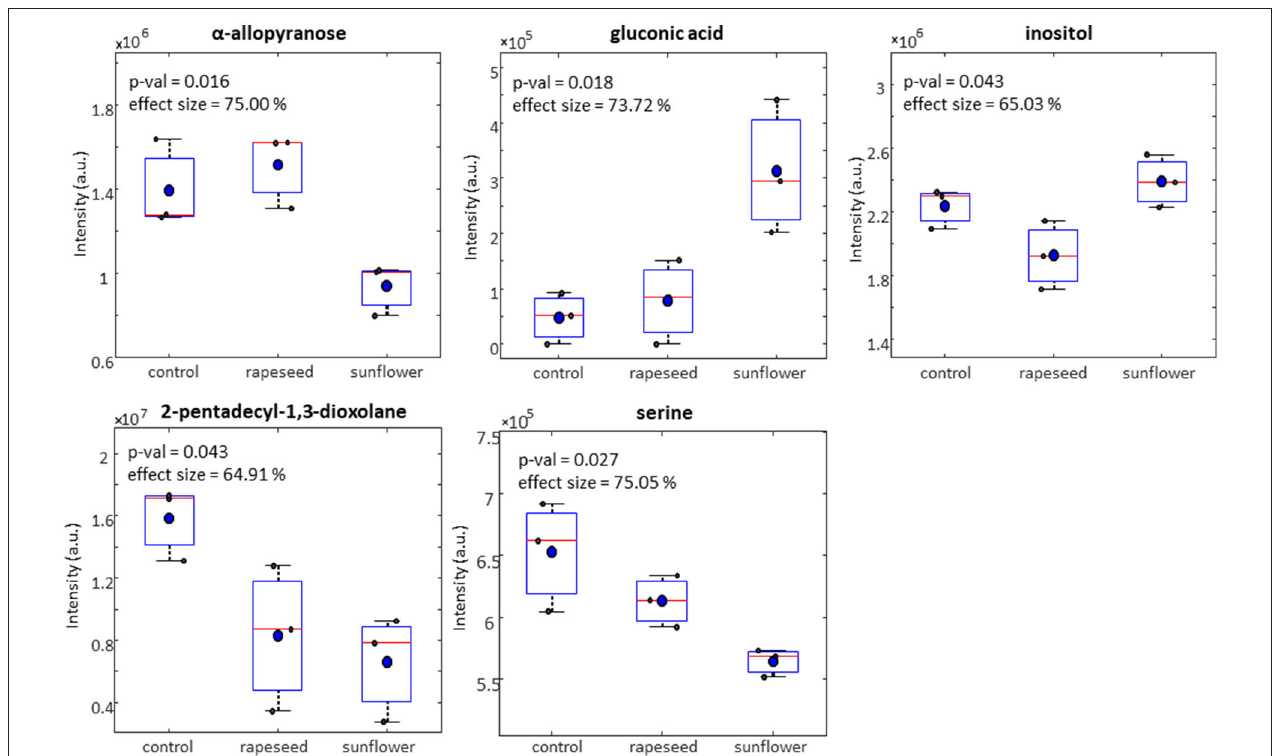
FIGURE 2 | Relative concentrations of goat milk metabolites detected by GC-MS across control, rapeseed oil and sunflower oil diets.